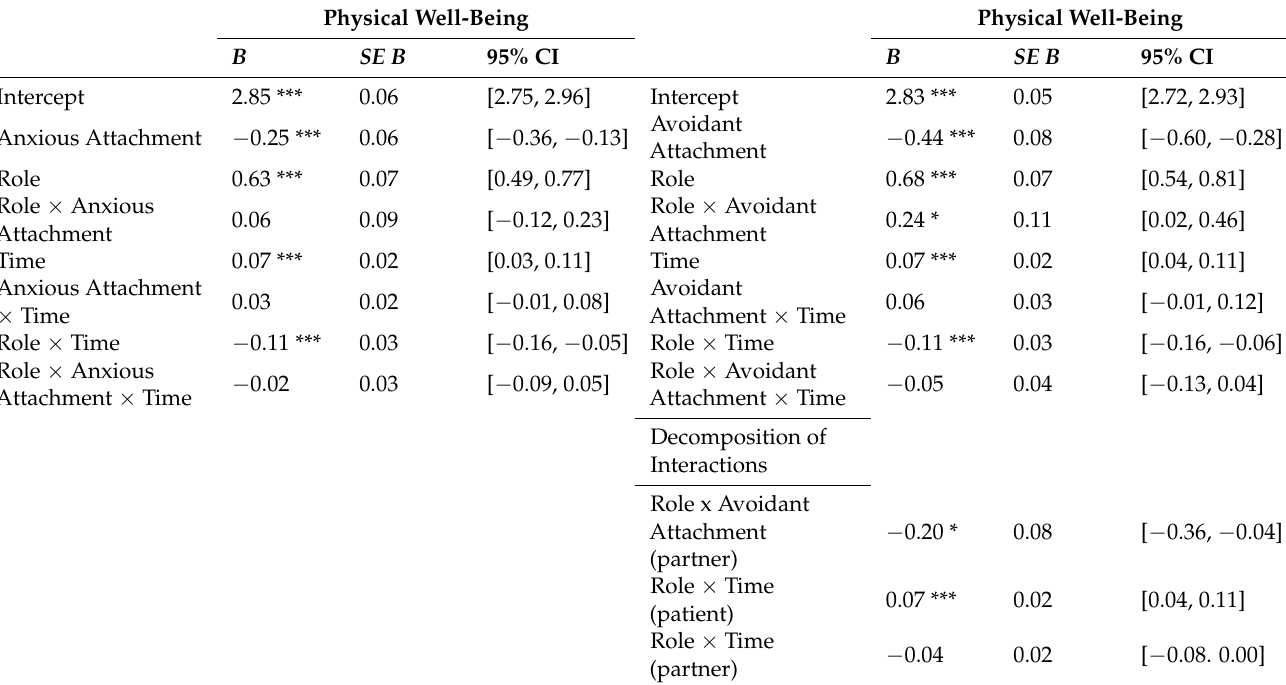
Table 5. Three-level mixed effect models of physical well-being, time, and attachment for patients and